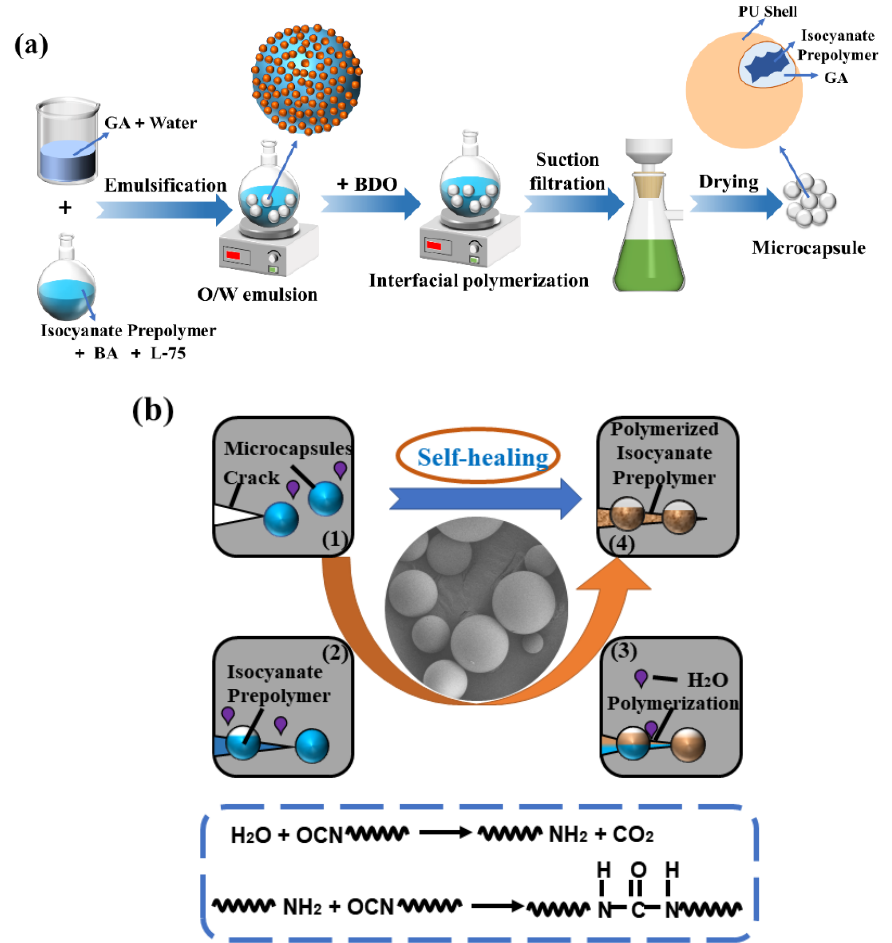
Figure 2. ( a ) Preparation path diagram of microcapsules. ( b ) Mechanism diagram of the self-healing of isocyanate prepolymer of isocyanate prepolymer microcapsules.